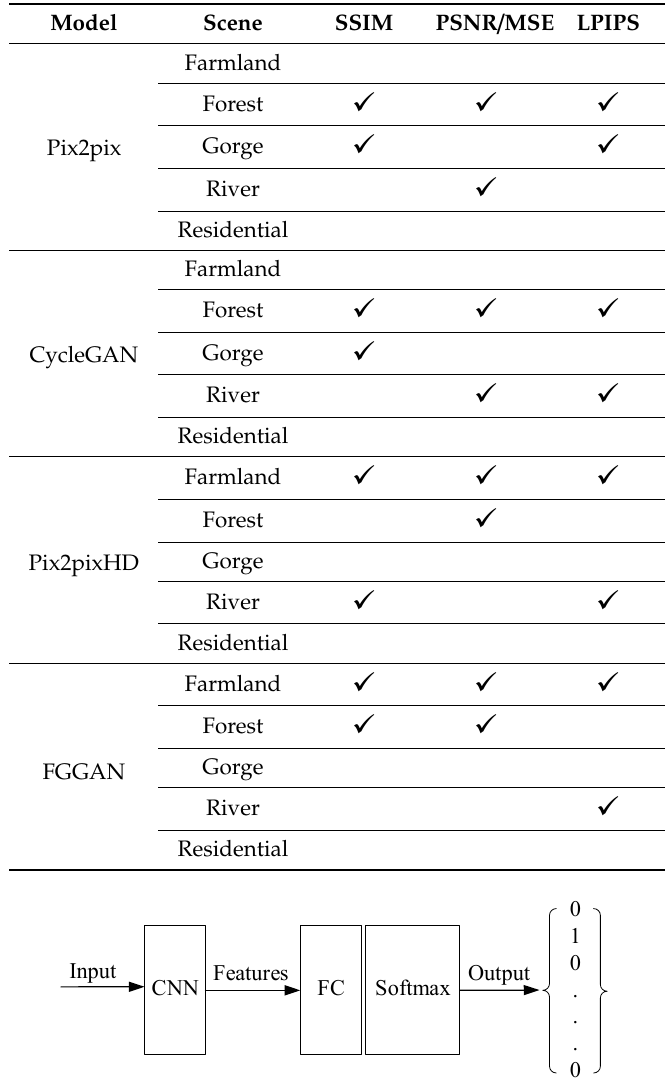
Table 5. Exploration of finding the most suitable scenes for each translation model.